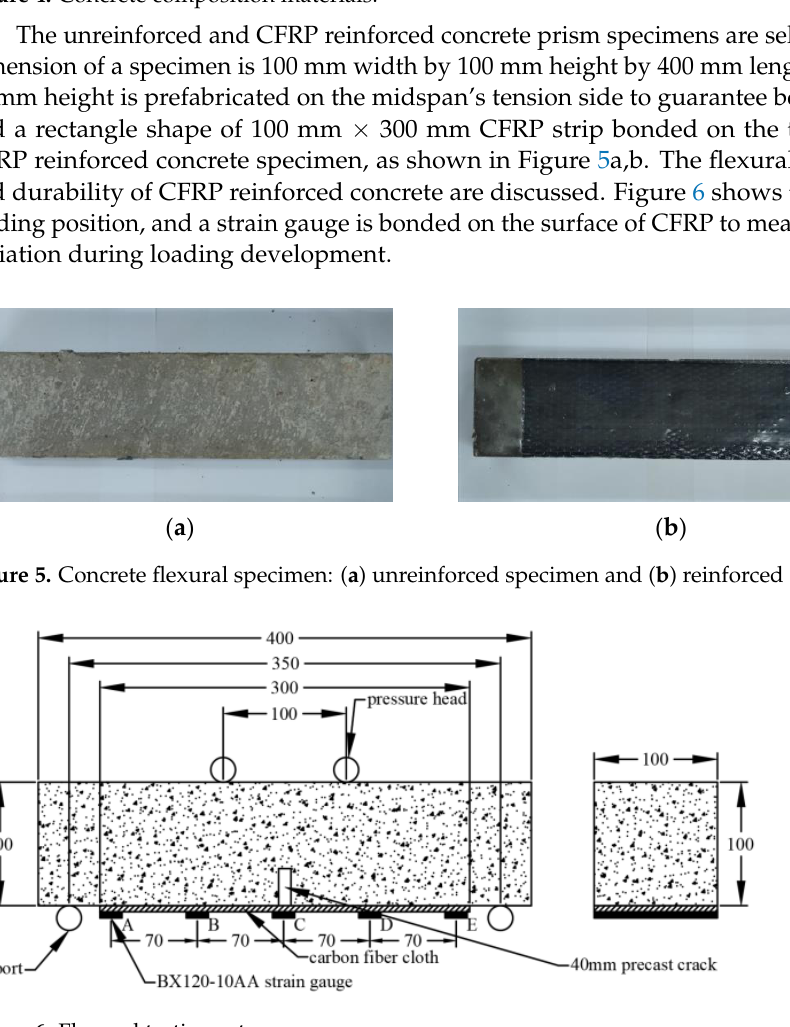
Figure 4. Concrete composition materials. Table 2. Concrete mix proportion.